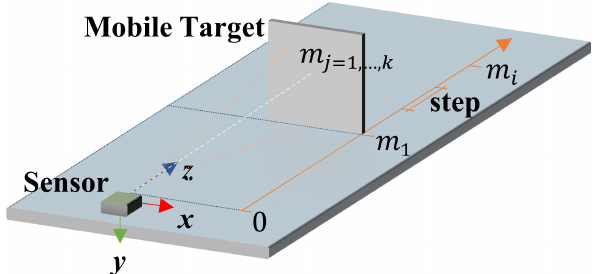
Figure 11. Schematic for evaluating accuracy, repeatability, and total error, in range of the axis of the position